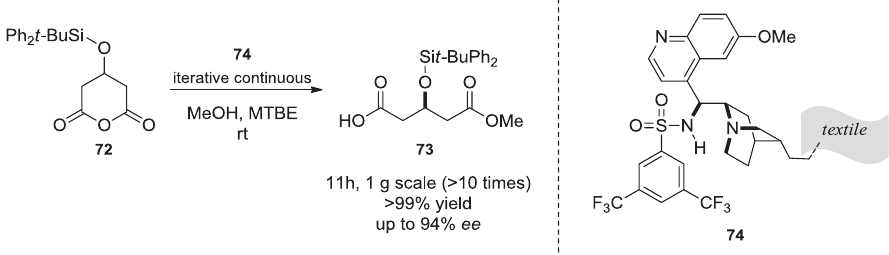
Figure 18. ‘ OrganoTexCat ’ for the desymmetrization of silylated glutamic anhydride, from Ref. [96, 97]. The reaction is performed under continuous conditions, in a fl ow reactor packed with 74.